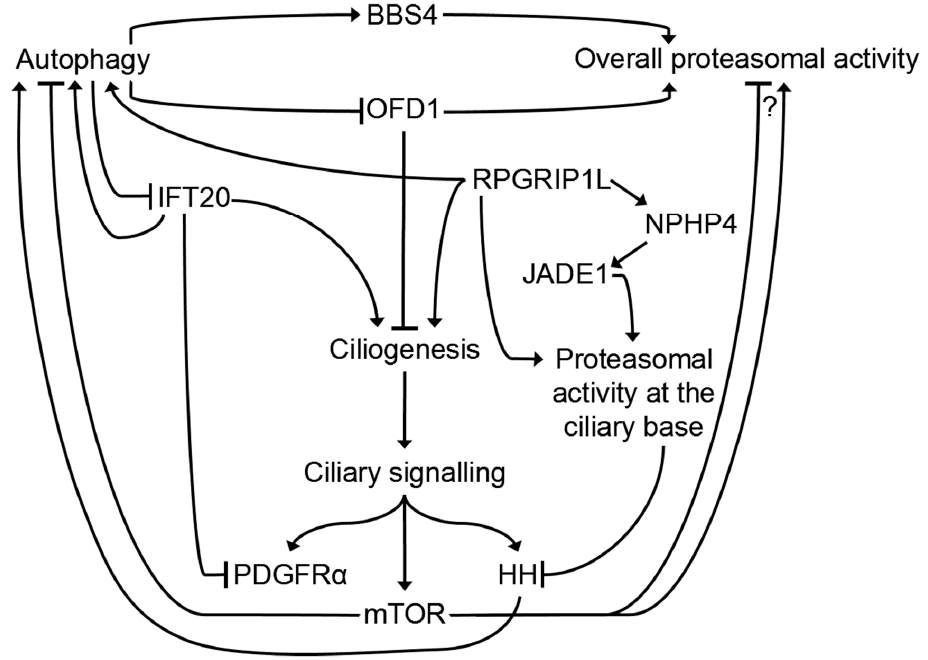
Figure 3. Complex network of the cilia-related crosstalk between the UPS and autophagy. Autophagy is able to regulate overall proteasomal activity in a positive or negative manner via BBS4 or OFD1. In addition, autophagy regulates ciliogenesis via OFD1 and/or IFT20 and thereby affects ciliary signalling. In turn, several cilia-mediated signalling cascades, like HH and mTOR signalling, modulate autophagy. Moreover, mTOR signalling regulates the overall proteasomal activity either positively or negatively (which is a matter of fierce debate). Additional cilia-associated proteins, like IFT20 or RPGRIP1L, regulate ciliogenesis as well as autophagy, whereby RPGRIP1L is also able to regulate the activity of the ciliary